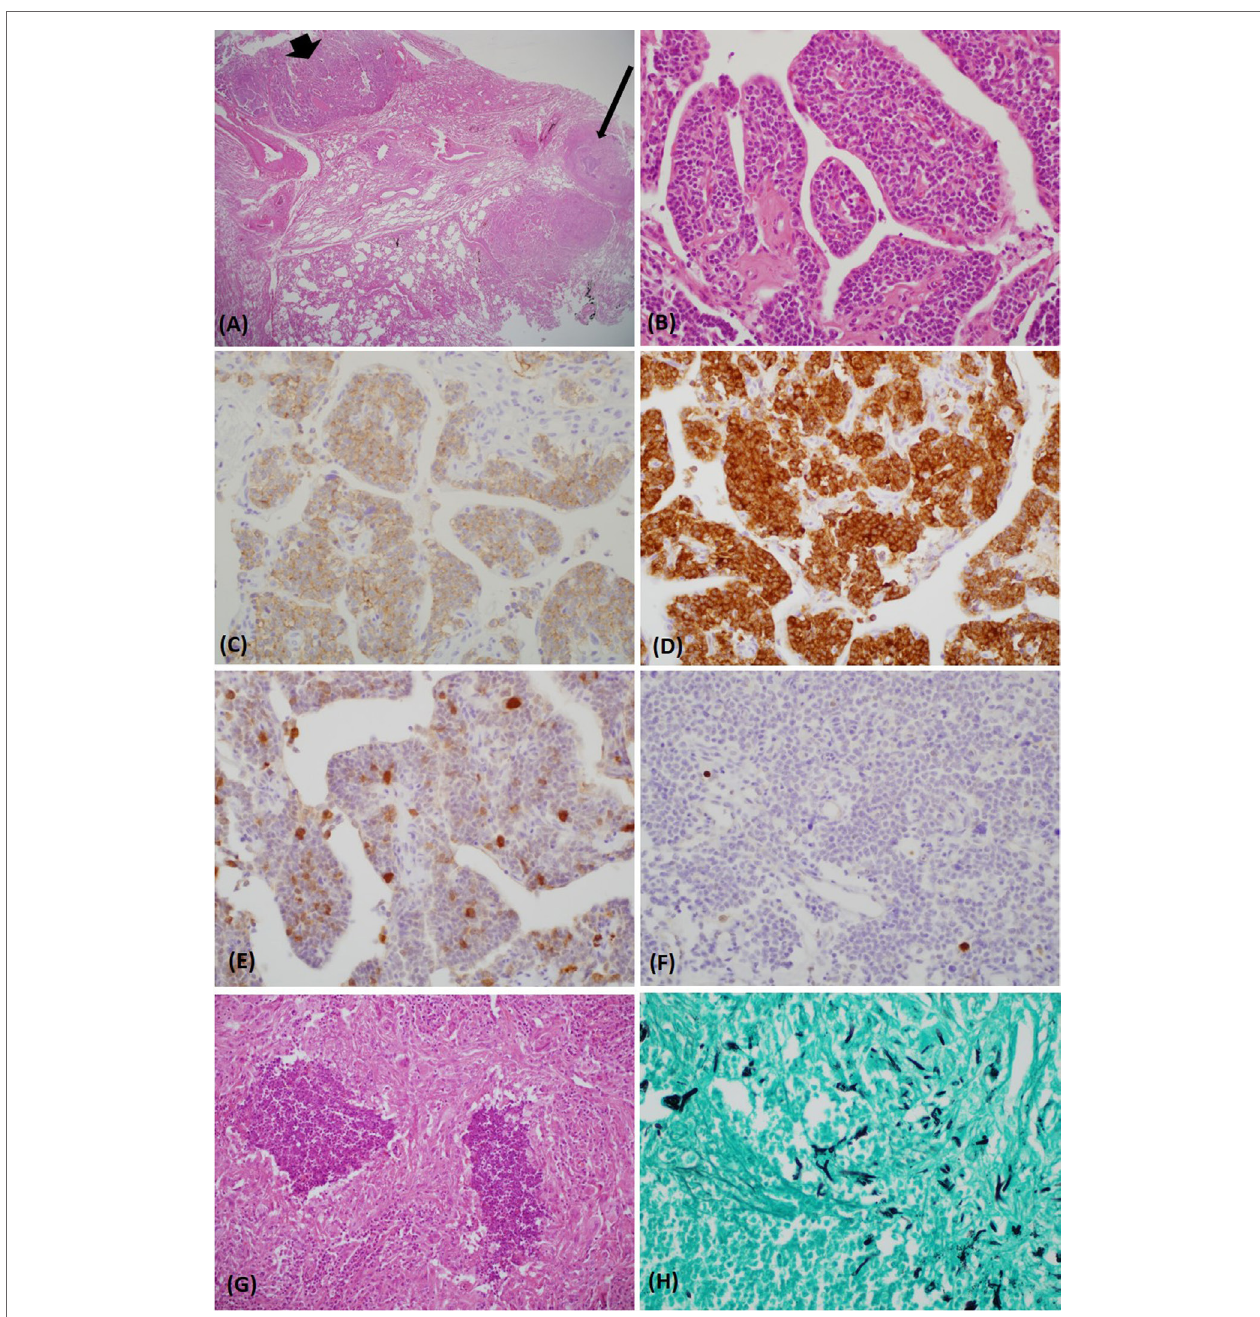
FIgURe 2 | The carcinoid tumor (bold arrow) and necrotizing granuloma (thin arrow) were in close proximity [hematoxylin and eosin (H&E) stain, × 12.5] (a) . The tumor consisted of uniform polygonal cells with a salt–pepper chromatin pattern (H&E stain, × 400) (b) . Upon immunohistochemical staining, the tumor was immunoreactive for CD 56 (C) , synaptophysin (D) , and adrenocorticotropic hormone (e) . The Ki-67 index was very low ( < 2%) (F) . A lesion abutting the carcinoid tumor exhibited chronic granulomatous inflammation with necrosis (H&E stain, × 400) (g) . Gomori methenamine-silver stain revealed acutely branching and septated fungal hyphae within the necrotic tissue ( × 400) (H)